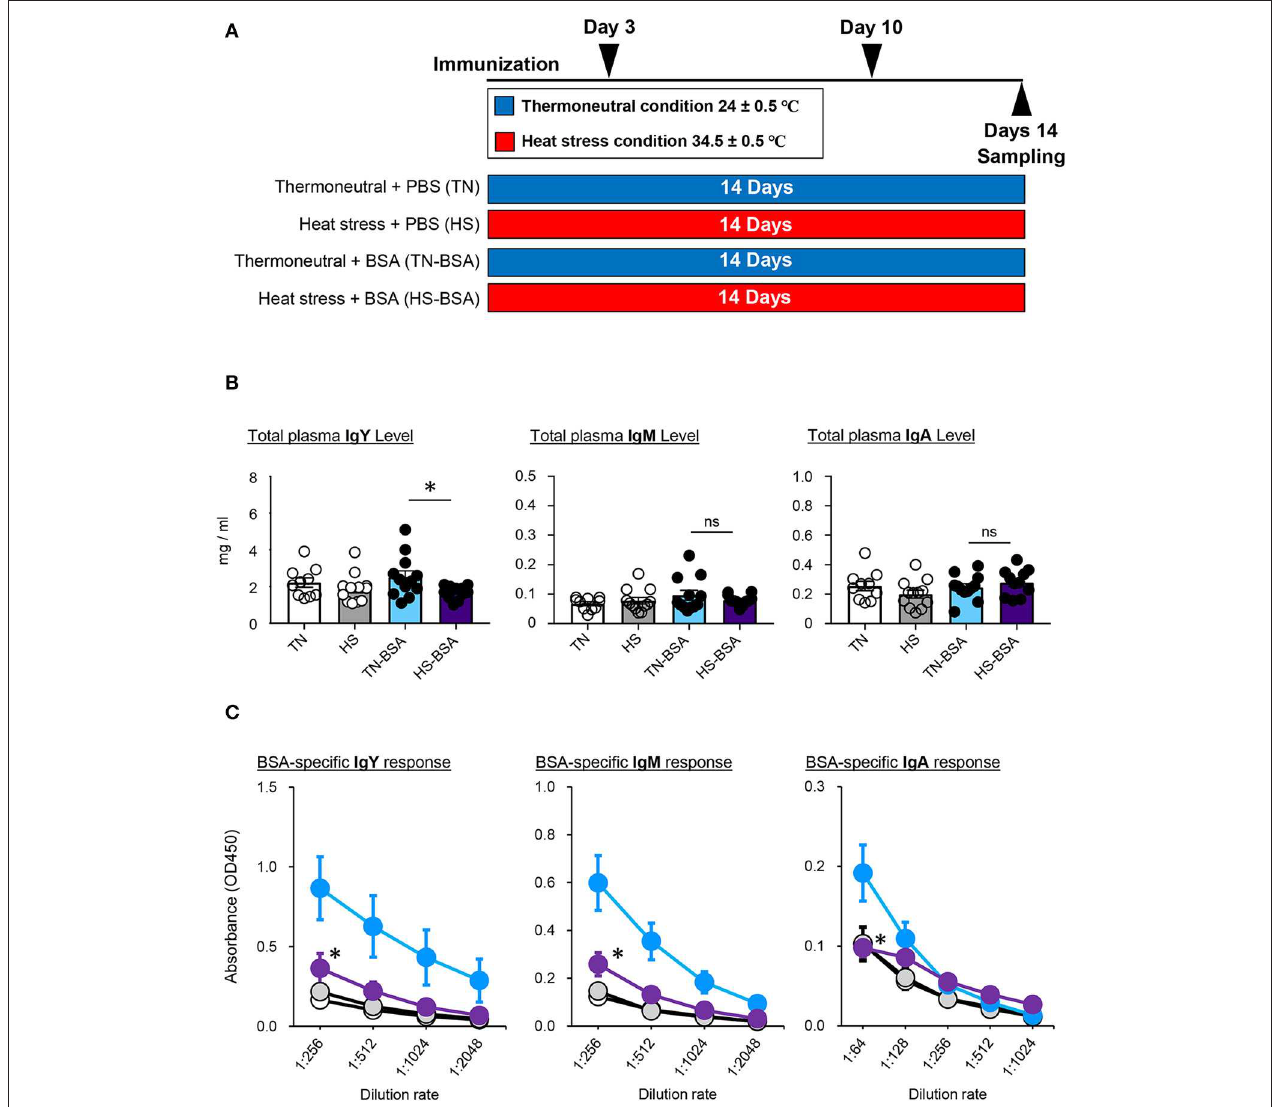
FIGURE 2 | Antigen-specific immune response of broiler chickens reared in the HS condition (A) . The experimental schedule is summarized. All birds were maintained in either TN or HS condition throughout the 14-days experimental period. To assess antigen-specific immune responses of heat-stressed chickens, broiler chickens under the TN (TN-BSA) and HS (HS-BSA) conditions were immunized intramuscularly with 10 µ g of BSA on days 3 and 10 of the experiment. As a control, other broiler chickens, maintained under the TN and HS conditions, were immunized intramuscularly with phosphate-buffered saline on days 3 and 10 of the experiment. Blood samples were collected from the wing veins of all chickens 4 days after initial and booster immunization (B,C) . Total plasma IgY, IgM, and IgA levels (B) and BSA-specific IgY, IgM, and IgA responses (C) were analyzed by ELISA. Three experiments were conducted and a representative result was shown. The data are presented as means ± SE ( n = 10–12/group). * p < 0.05 compared between TN-BSA and HS-BSA (unpaired two-tailed Student’s t -test). Clear, TN; gray, HS; blue; TN-BSA; purple,